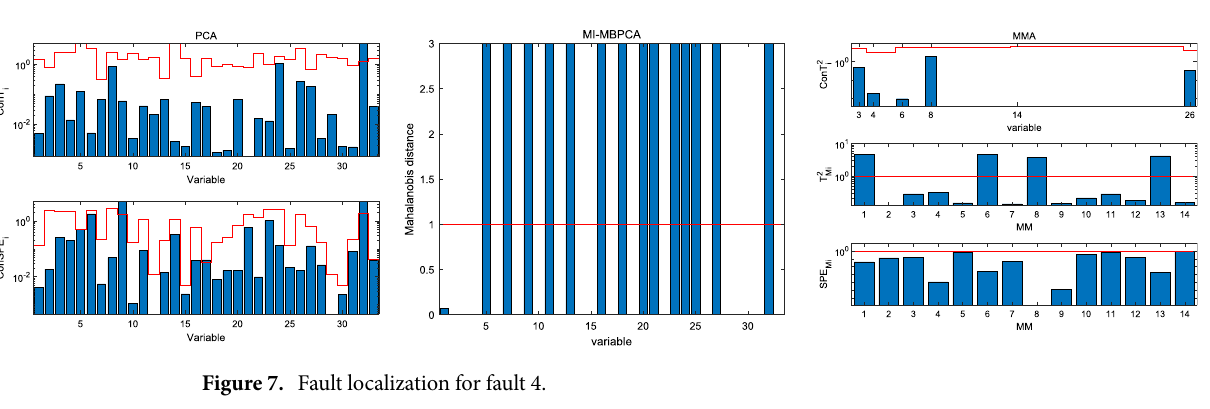
Figure 7. Fault localization for fault